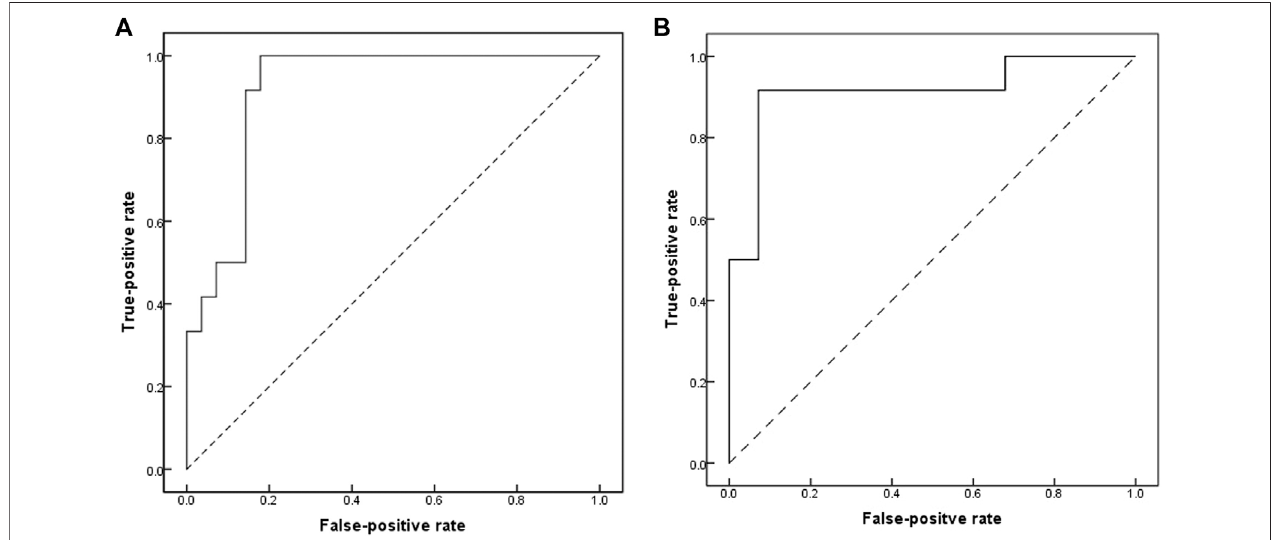
FIGURE 2 | Receiver-operating-characteristics (ROC) curves showing accuracy of methylation pro fi le of placental DNA CpG in prediction of CTDs. (A) cg04328562(CNN1); area under ROC curves (AUC) = 0.917 (95%CI, 0.831 – 1.0). (B) cg05167251 (chr2; HOXD9); area under ROC curves (AUC) = 0.917 (95%CI, 0.8 –